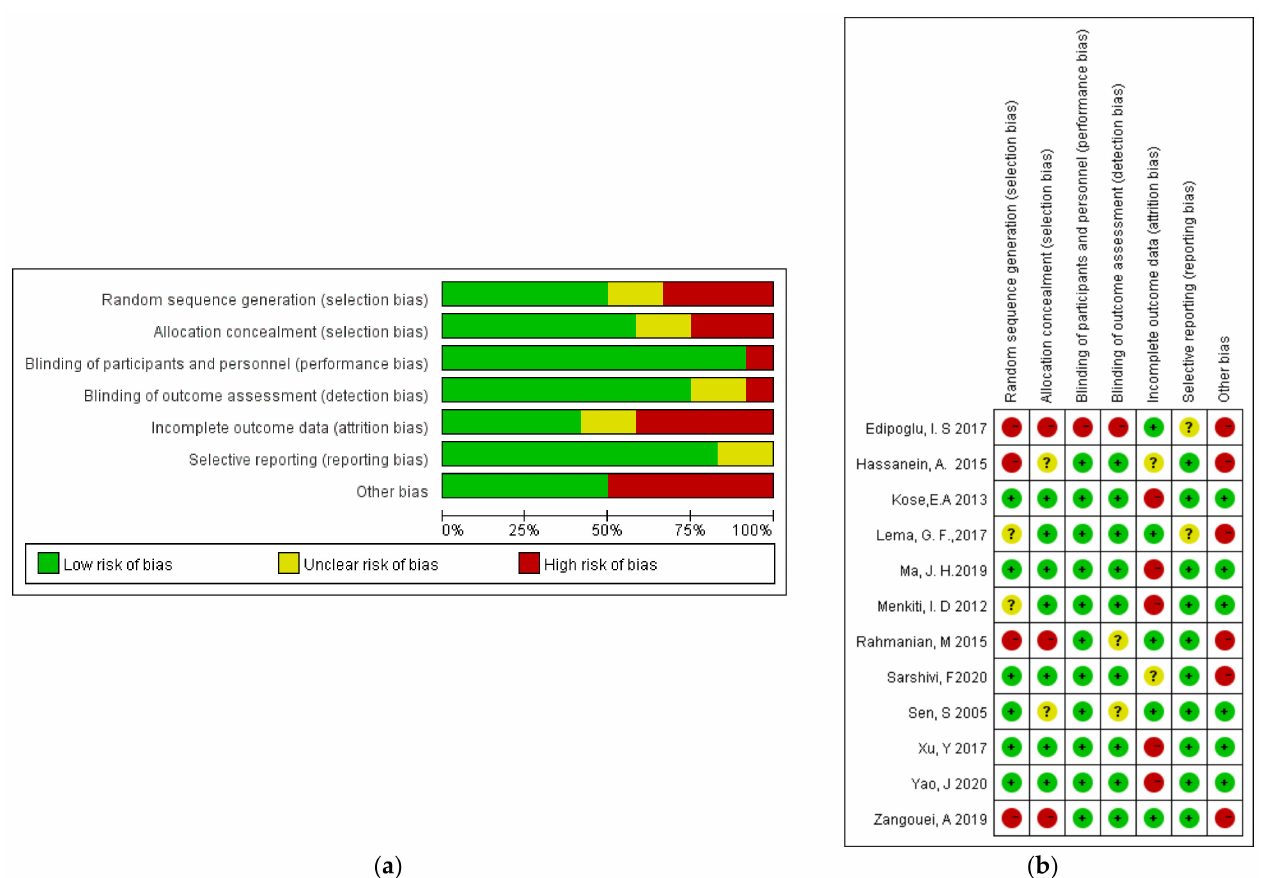
Figure 2. Risk of bias: ( a ) a summary table of the review authors’ judgements for each risk of bias item for each study; ( b ) a plot of the distribution of the review authors’ judgements across studies for each risk of bias item [12–23]. “+” Low risk of bias; “?” unclear risk of bias; “ − ” high risk of bias.